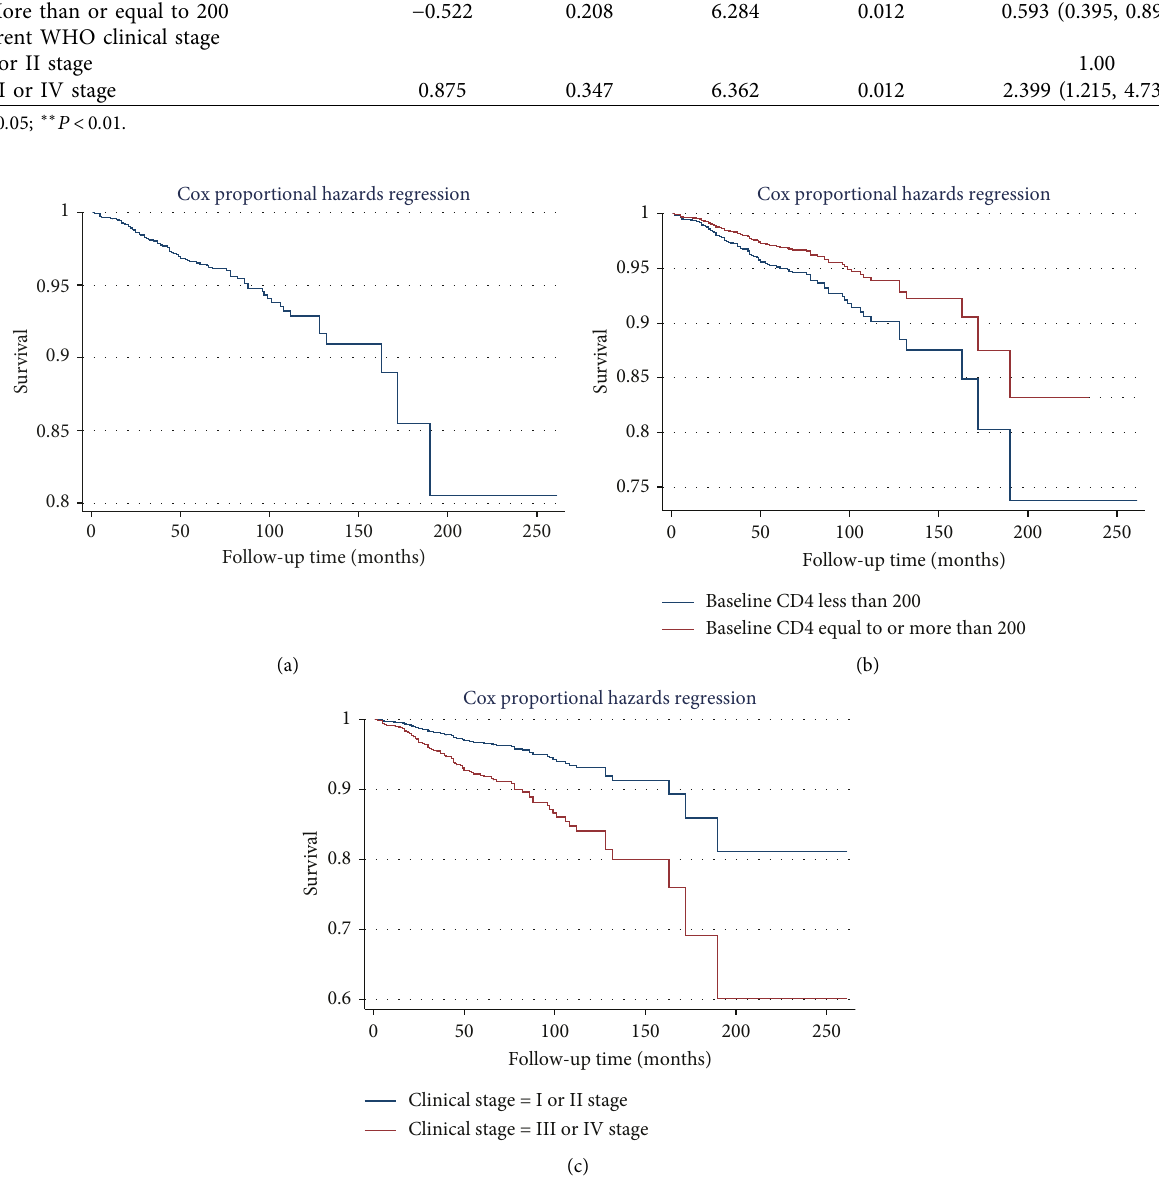
Figure 2: The survival curves of participating subjects: (a) overall survival curves; (b) survival curves of different baseline CD4; and (c) survival curves of different WHO clinical stages.